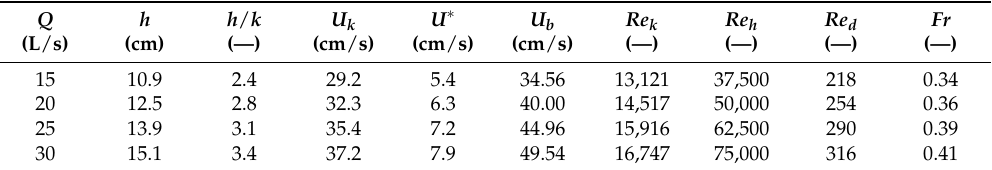
Table 2. Details of experimental